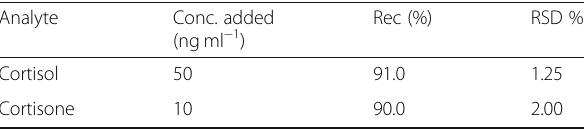
Table 2 The Recovery and RSD values of cortisol and cortisone standard solution spiked in the Zebrafish whole-body sample ( n = 3) Analyte Conc. added (ng ml − 1